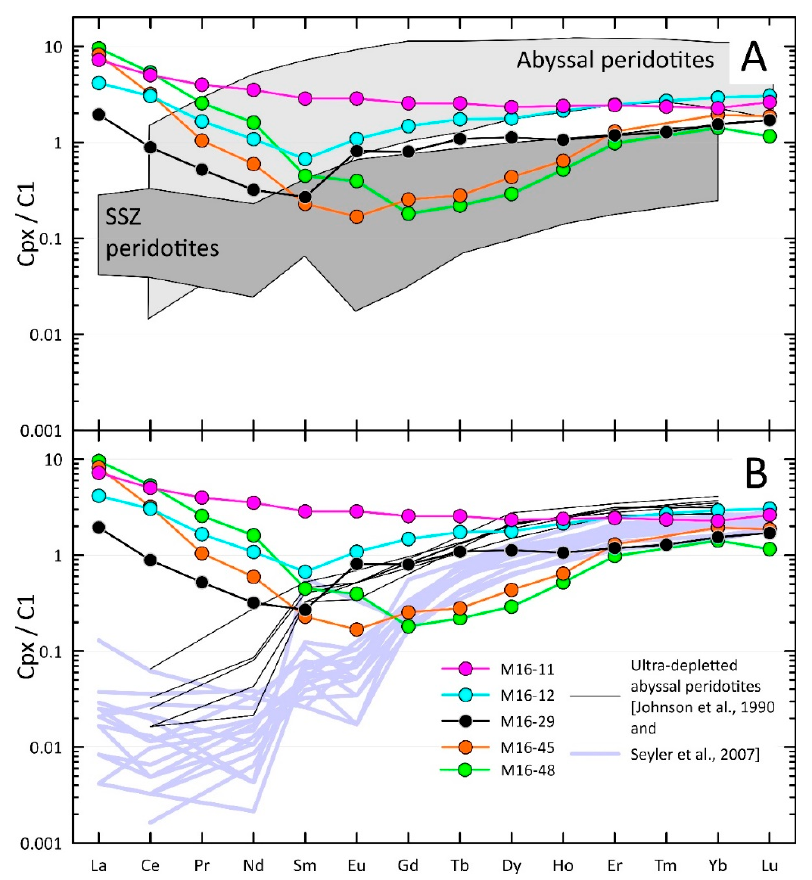
Figure 8. Chondrite-normalized [52] clinopyroxene rare-earth-element patterns for the Alag Khadny peridotites. ( A ) The field of abyssal-peridotite clinopyroxenes is after Johnson et al. [56]; supra-subduction zone (SSZ) peridotites are from [57,58]. ( B ) Ultra-depleted abyssal peridotites, [56]—black lines and [39]—violet lines.